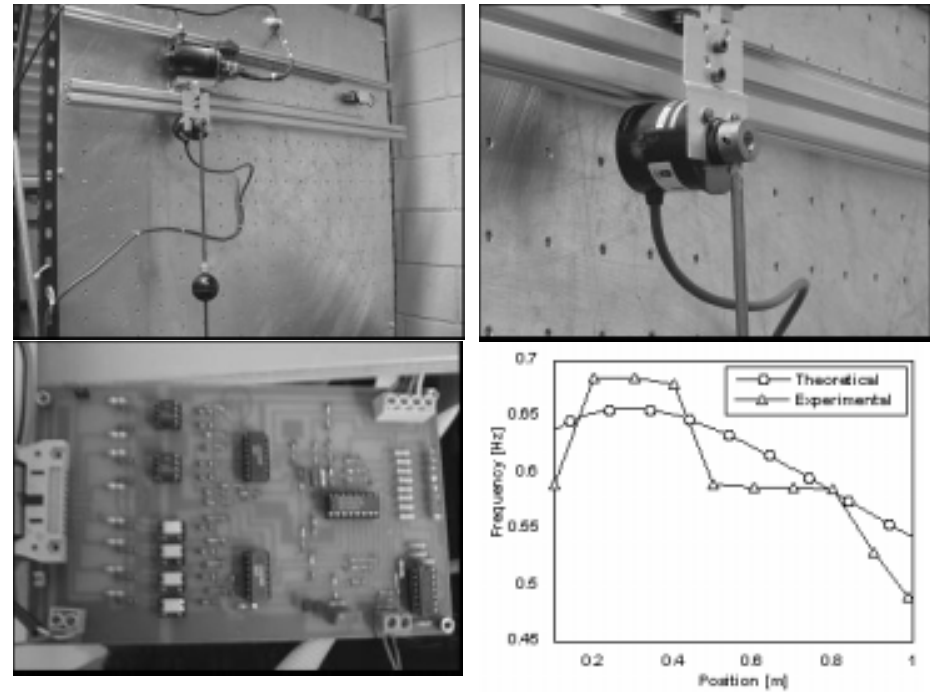
Fig. 10. (a) Experimental Set-up. (b) Absolute encoder acting as the joint between the rod and the trolley. (c) Digital to Analog converter. (d) Measured frequencies. 0 =